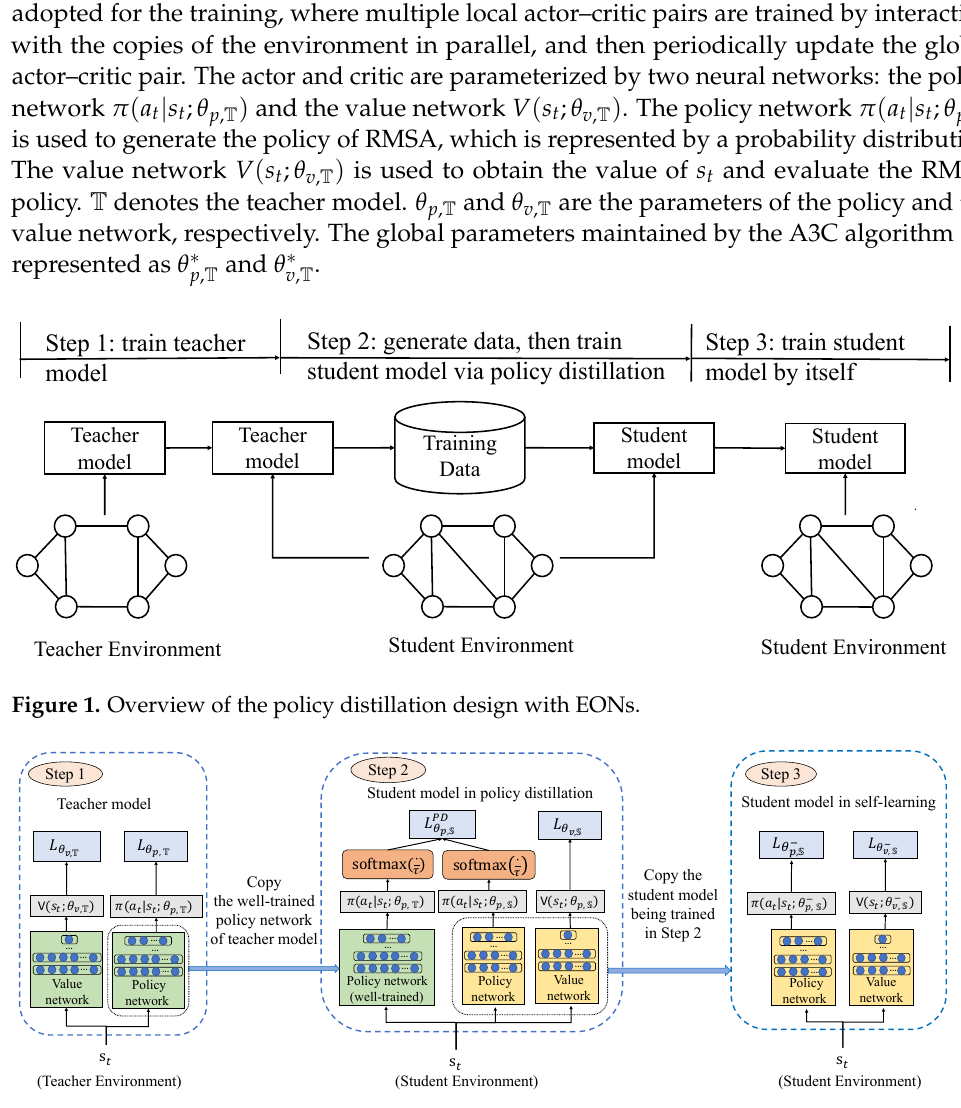
Figure 2. Detailed illustration of policy distillation design with